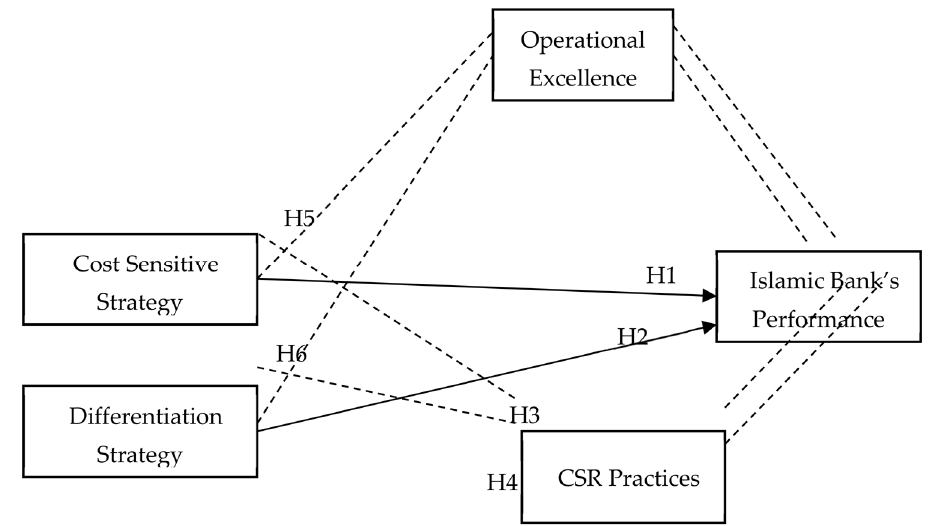
Figure 1. Conceptual Framework.